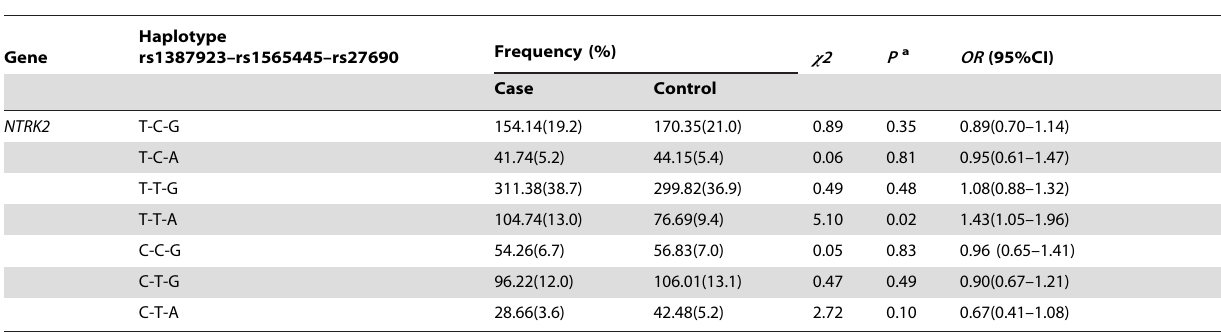
Table 3. Haplotype analysis of NTRK2 gene (rs1387923–rs1565445–rs276905).